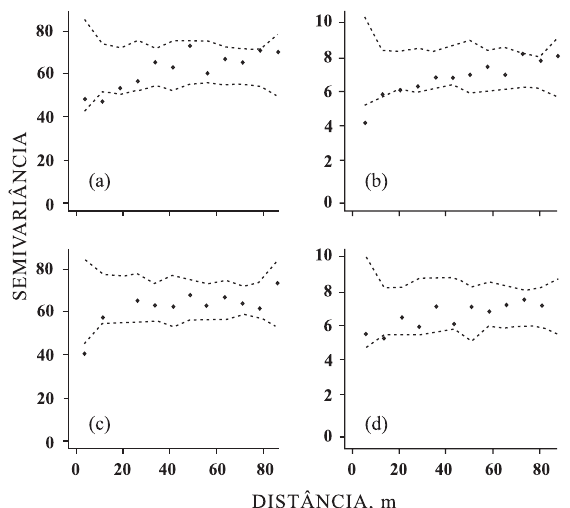
Figura 3. Limites dos semivariogramas experimentais omnidirecionais, considerando independência entre as amostras (envelopes) das variáveis Fe (a) e resíduos de MO (b), Mn (c) e H + Al